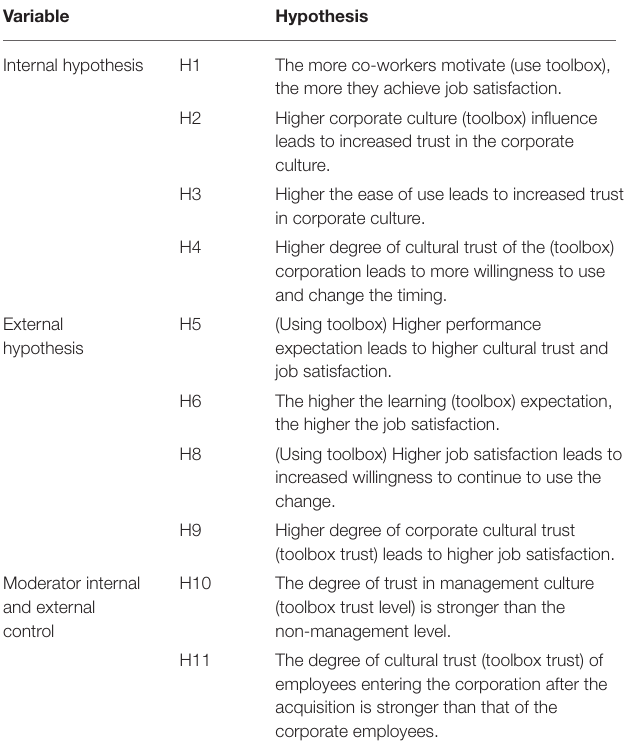
TABLE 3 | Statistics of valid